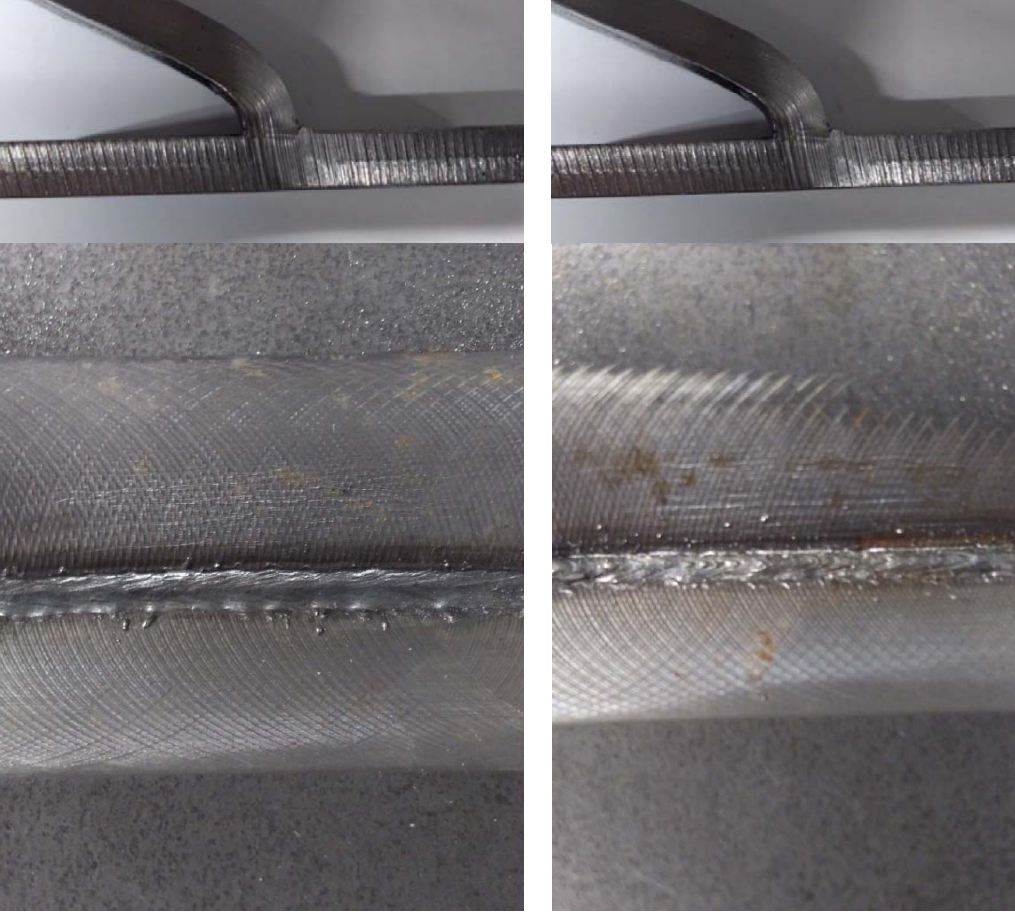
Figure 12. View of joints after bending test.